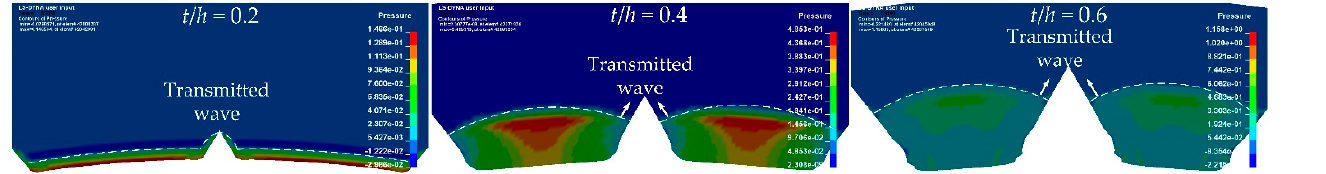
Figure 11. Propagation of the transmitted stress waves along the inclined groove wall.